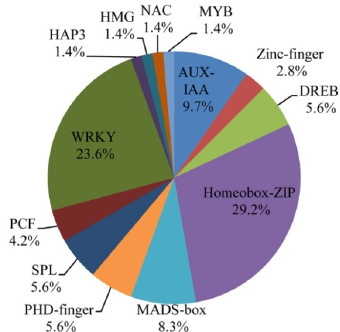
Figure 5. TF families identified in the two rice genotypes. Number of transcripts related to each specific family was clustered and shown as the percentage of the total number of TFs.